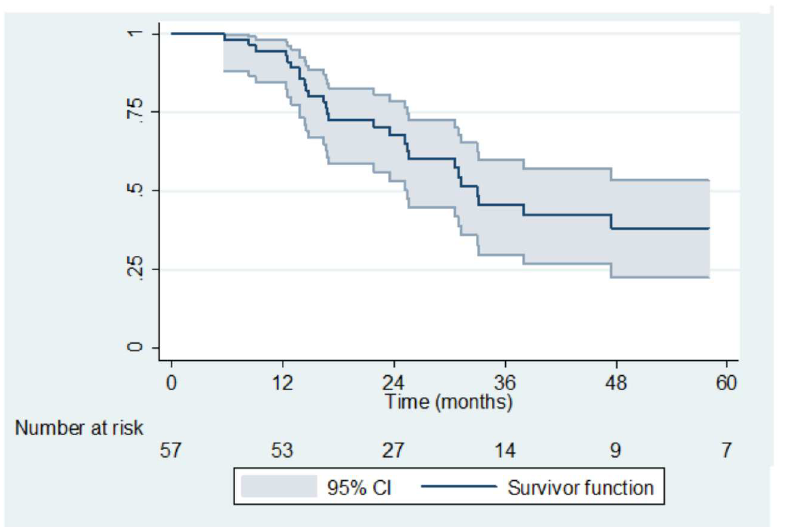
Fig 1. Loco-Regional Recurrence Free Survival.